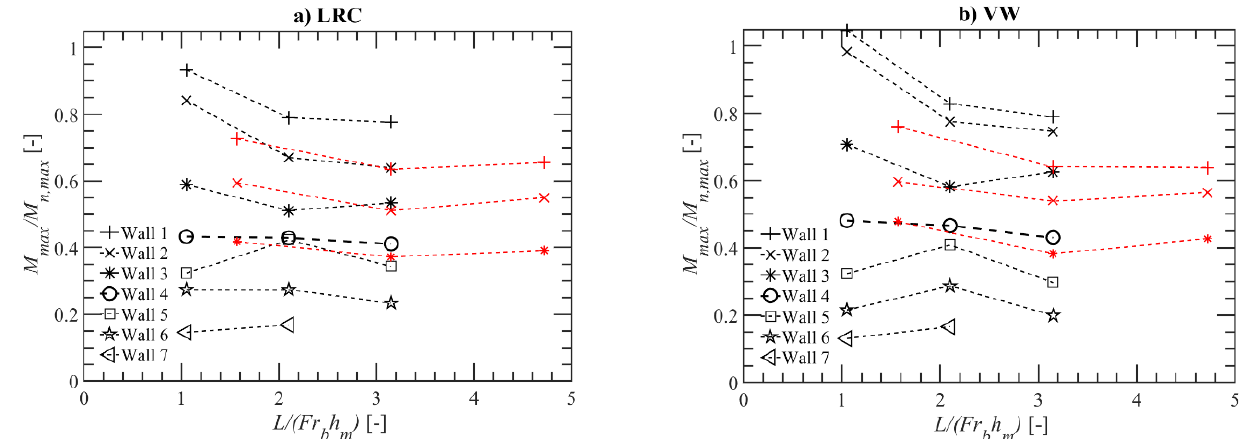
Figure 19. Effect of L in the overturning moment variation.